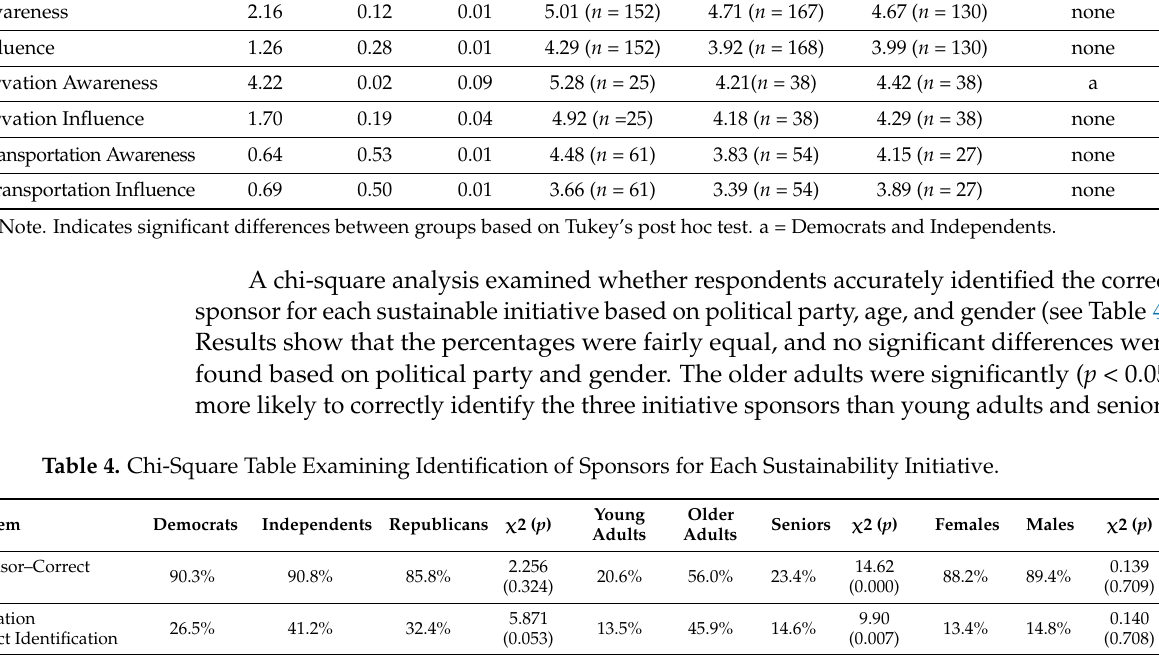
Table 5. Overall, the path model showed good fit (Democrat n = 155, Independent n = 134,